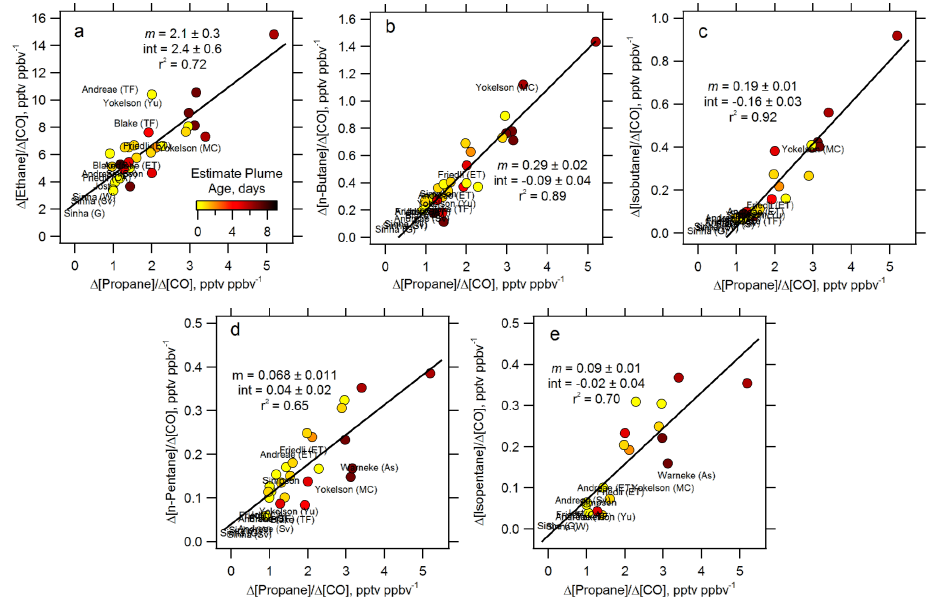
Fig. 8. Comparison plots of the NEMRs to CO observed during ARCTAS for several light alkanes against propane determined using the WAS data, colored by the estimated BB plume age. Also shown are the corresponding literature NEMR ratios listed in Table 4. Linear least-squares fits to the ARCTAS data are shown, with details for the fits listed on each full-scale plot.